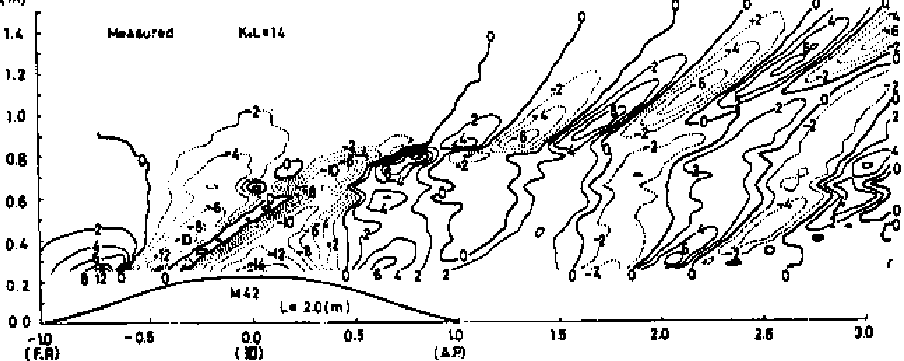
Figure 5. Contours of waves, wave height in mm. In the bow you can see how the retaining waves shift the Kelvin wave system Fn = 0.267. The inscription at the top: “measured and k o L = 14”; on the contour—”M42 and L = 20